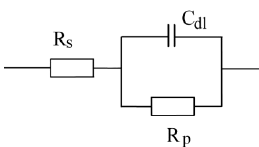
Figure 2. The Randles equivalent circuit [12,19].